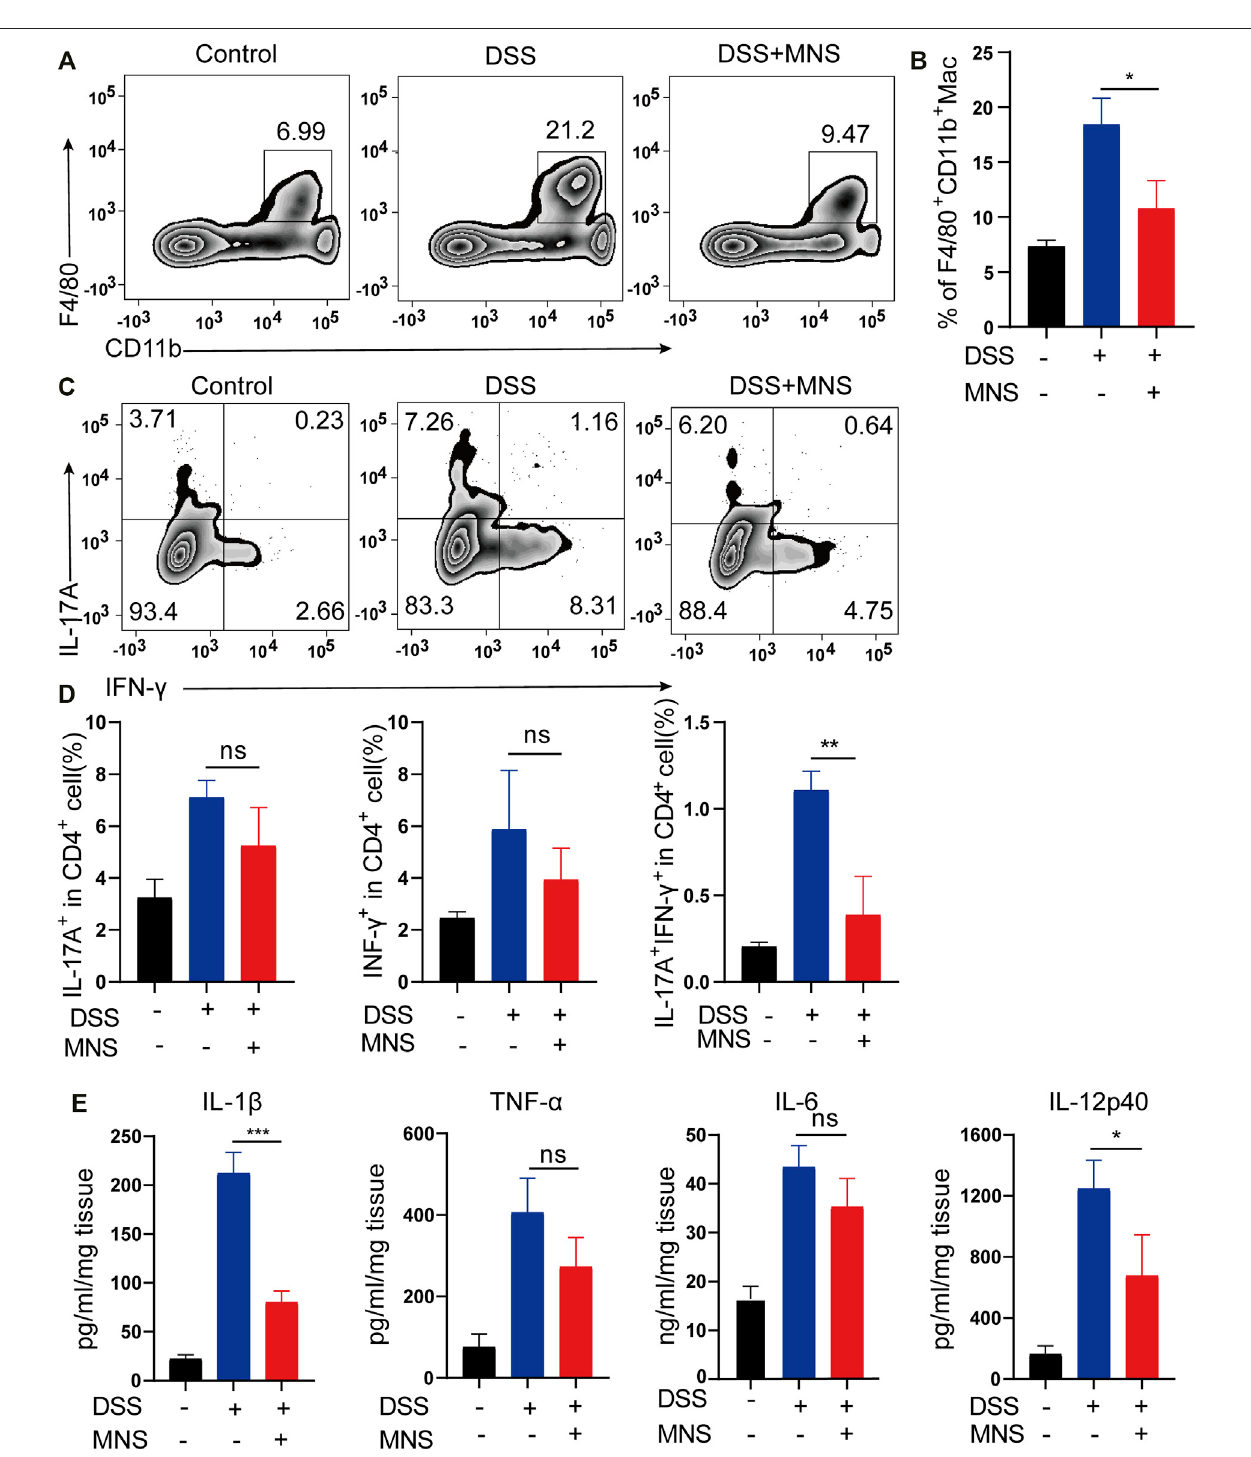
FIGURE 5 | MNS attenuated macrophage in fi ltration and regulated cytokine secretion of mouse colon with DSS-induced colitis. (A,B) F4/80 + CD11b + labeled macrophages inin fi ltratedcolontissue were detected by fl owcytometry. (C) IL-17A + IFN- γ + helper Tcellsincolontissuewereanalyzed by fl owcytometry byIL-17Aand IFN- γ intracellular staining. (D) Proportion analysis of IL-17A + , IFN- γ + , and IL-17A + IFN- γ + cells in CD4 + T cells. (E) Washed colon tissues were weighed and cultured ex vivo for 24h,and the supernatants ofcolon biopsywere analyzed using TNF- α , IL-1 β ,IL-6, and IL-12p40 ELISAkit. N=3mice/group.Datawerepresented asthe mean ± standard error of the mean (SEM); ns = not signi fi cant. * p < 0.05, ** p < 0.01, and *** p < 0.001 vs. the DSS group.